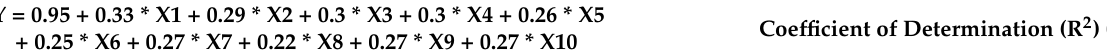
Table 5. Multi-regression for stress estimation for